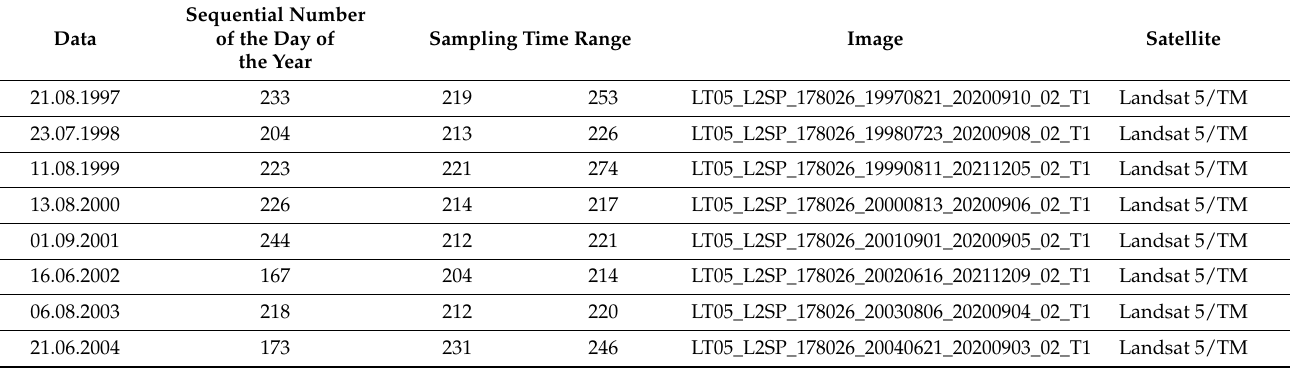
Table A2. Landsat 5/TM, Landsat 7/ETM, and Landsat 8 OLI images used in the